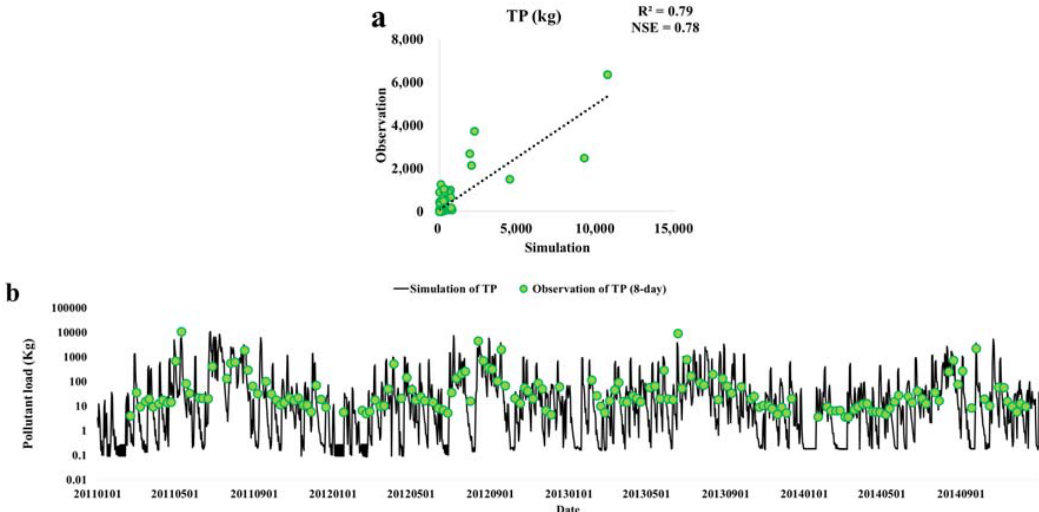
Figure 7. Comparison between simulated TN ( a ) and observed TN ( b ) at Pyungchang A watershed (2011–2014).